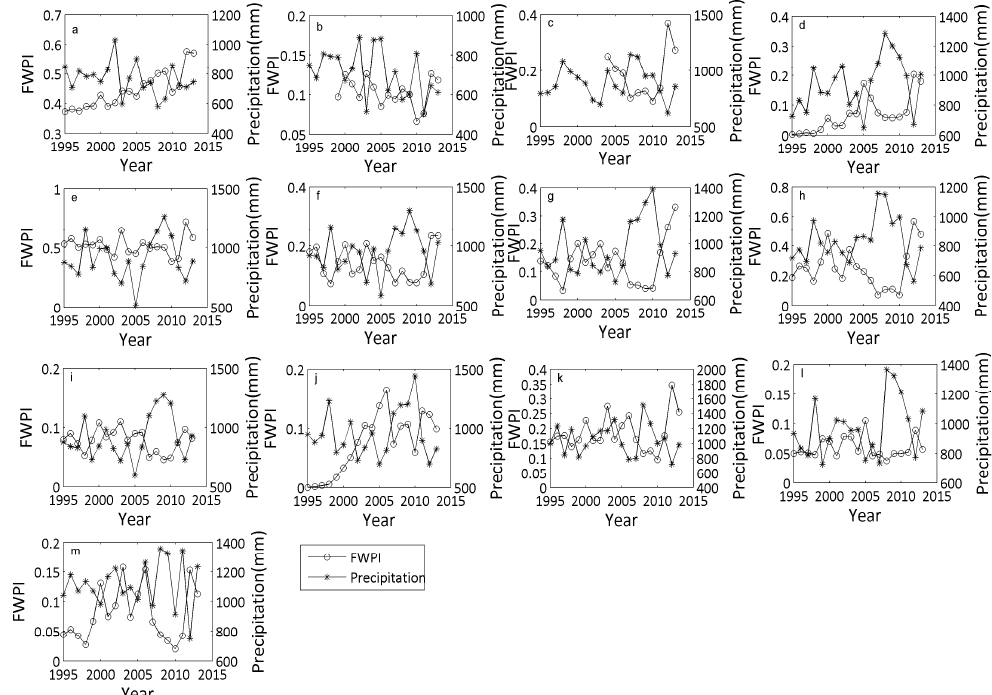
Figure 4. Freshwater provision index ( FWPI ) versus precipitation between 1995 and 2013 for 13 watersheds in the UMRB: Twin Cities ( a ); Lower Minnesota ( b ); Turkey ( c ); Maquoketa ( d ); Copperas ‐ Duck ( e ); Lower Wapsipinicon ( f ); Skunk ( g ); Upper Iowa ( h ); Lower Iowa ( i ); Lower Des Moines ( j ); Peruque ‐ Piasa ( k ); Lower Illinois ( l ); Upper Mississippi ‐ Cape Girardeau ( m ).